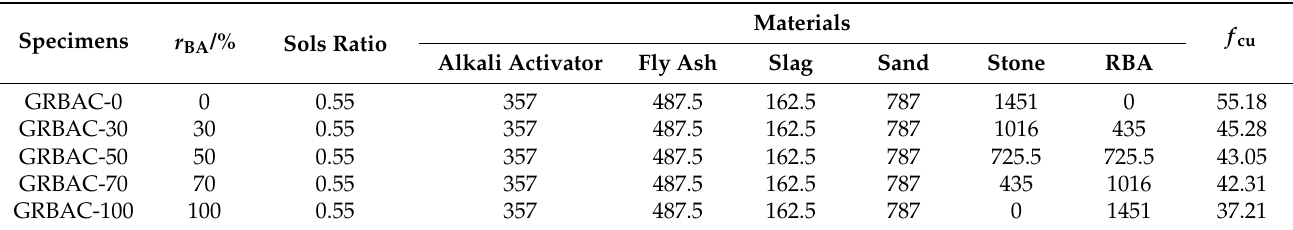
Table 3. The mix design for GRBAC (kg · m − 3 ) and measured strength (MPa).